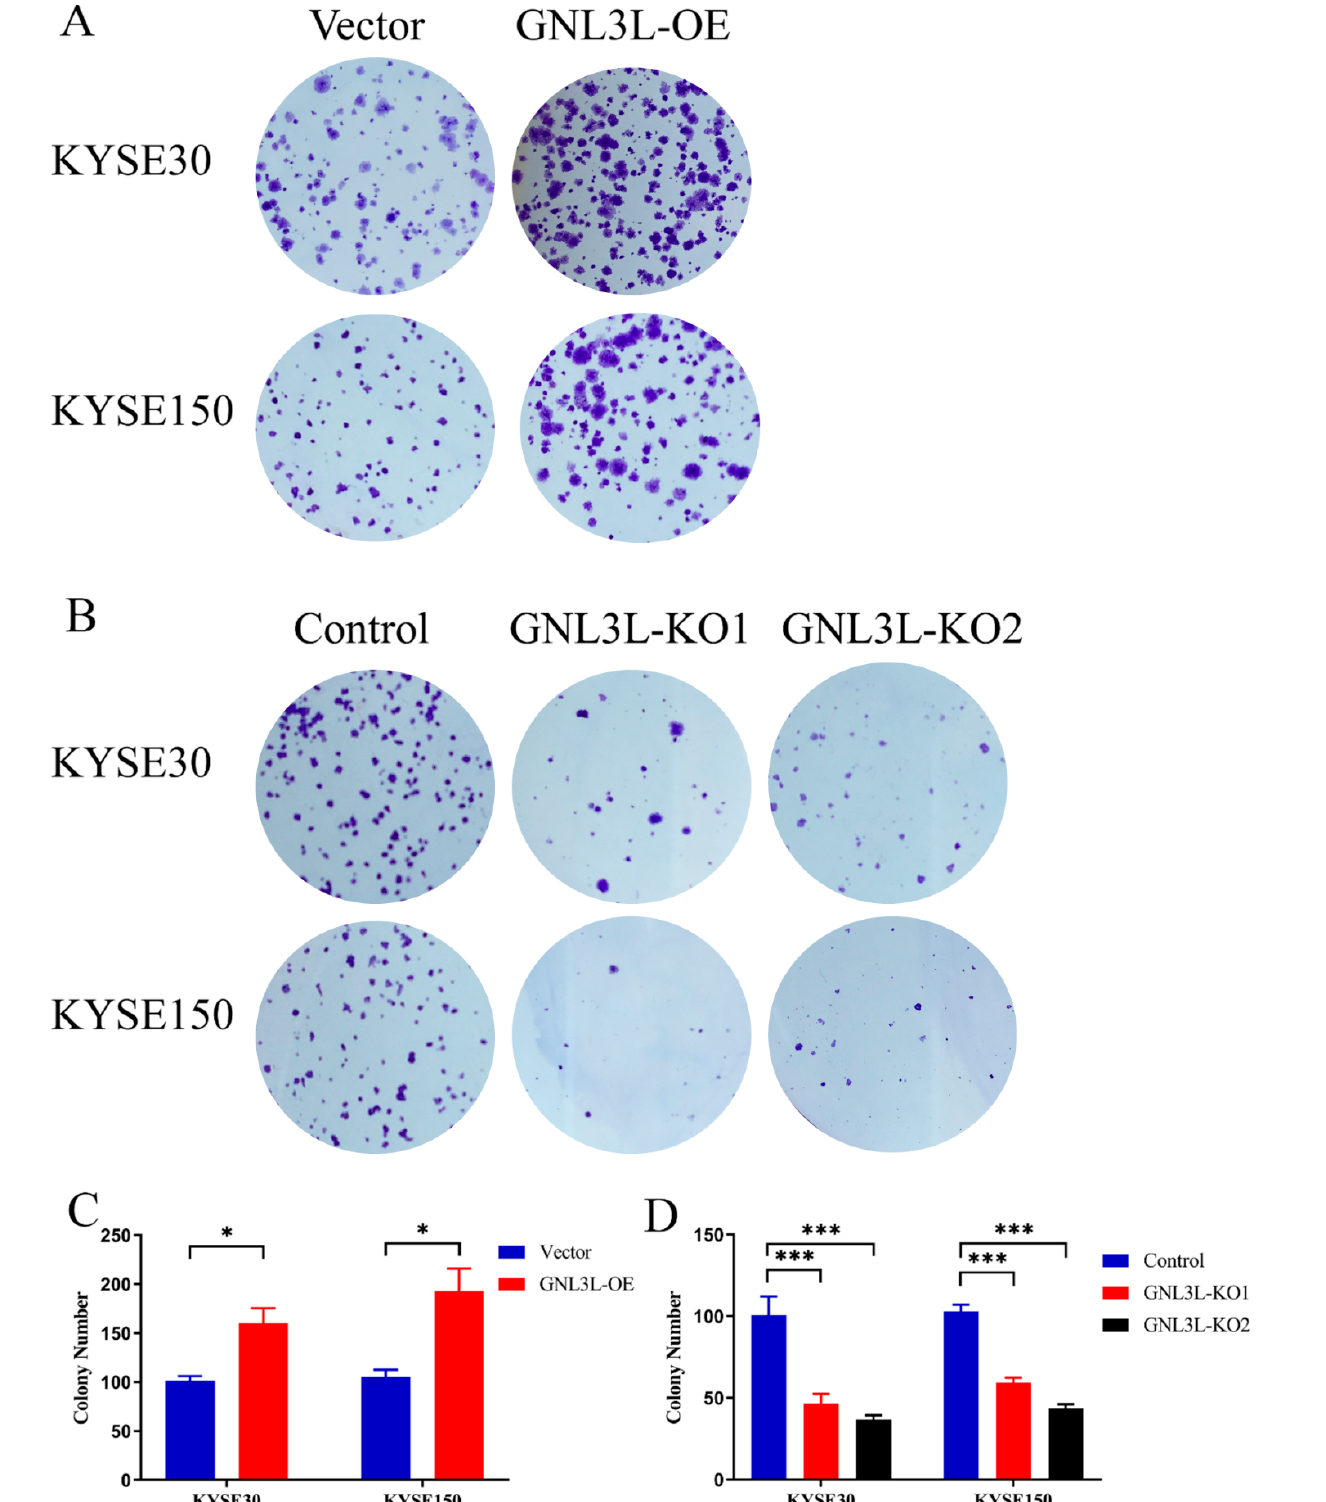
Figure 12. Results of clone formation assays for GNL3L overexpression and knockdown. ( A , C ) Graph of the results of clone formation assays with GNL3L overexpression. ( B , D ) Graph of the results of clone formation assays for GNL3L knockdown. * p < 0.05; *** p < 0.001.